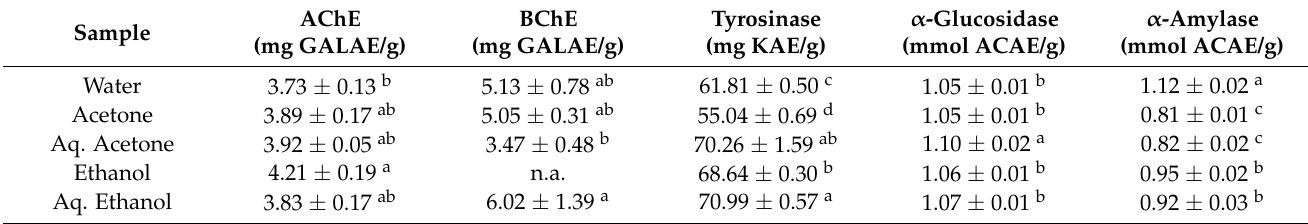
Table 4. Enzyme inhibitory activity (mg standard equiv./g extract DW) of extracts from Cla- dium mariscus (sawgrass) seeds: acetyl- (AChE) and butyryl-cholinesterase (BChE), tyrosinase, α - glucosidase, and α